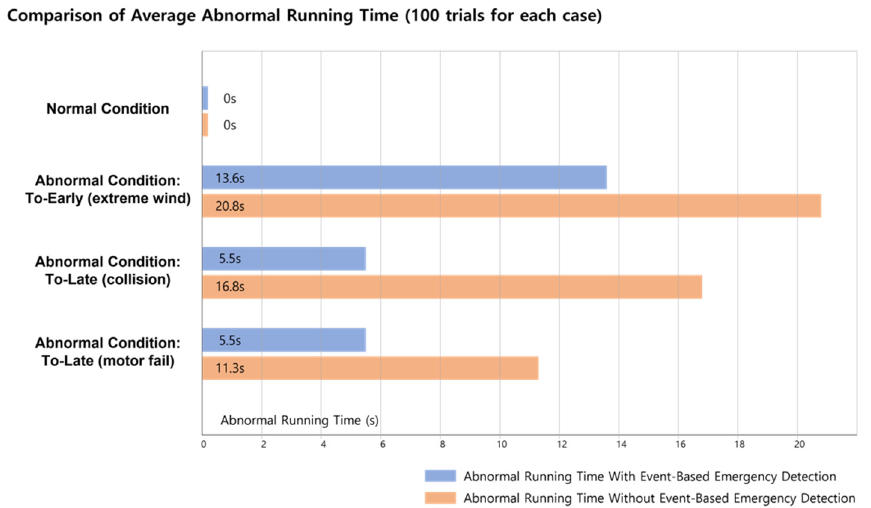
Figure 9. Comparison of average abnormal running time. Each case was conducted 100 times to reasonably compare the results. It turned out that too-early cases took more time to detect than too-late cases, where both too-late cases were detected within about 5.5 s on average.